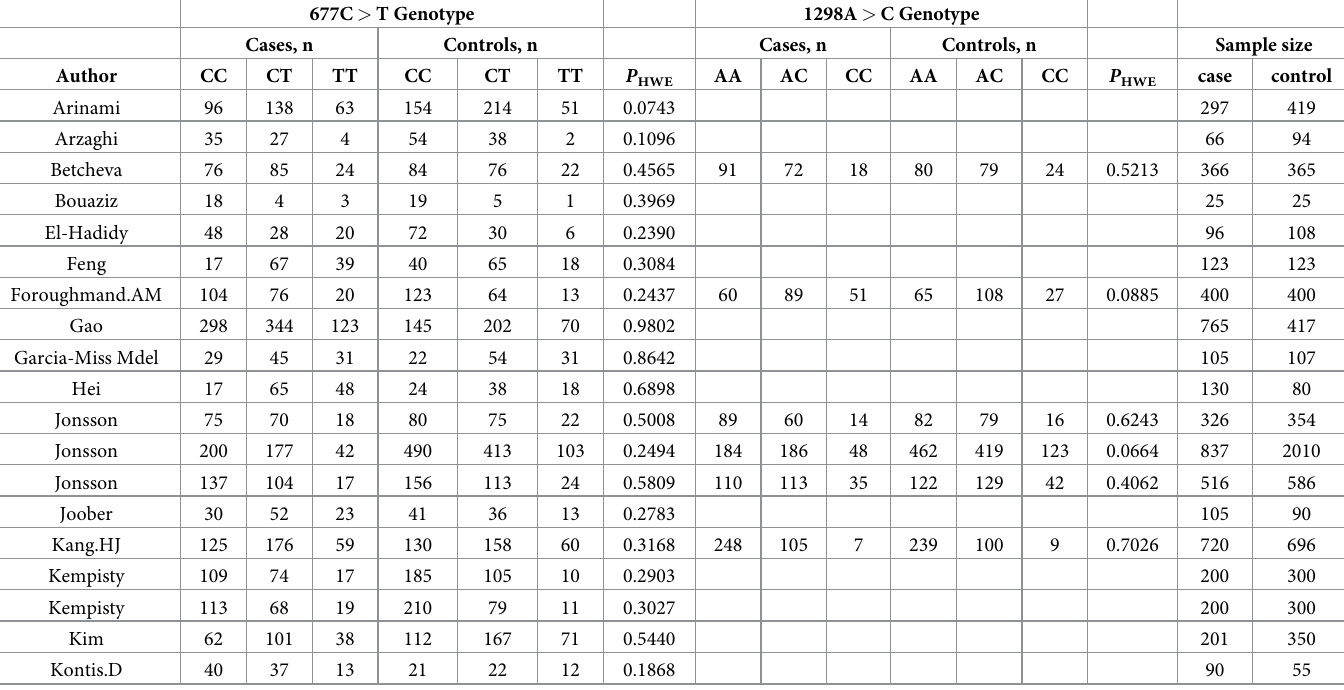
Table 4. Distribution of genotype and allele frequencies of the MTHFR 677C > T and 1298A > C polymorphisms in schizophrenia patients. 677C > T